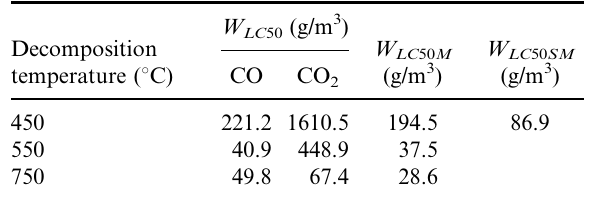
Table 10. Toxicometric indicators of modified polyester